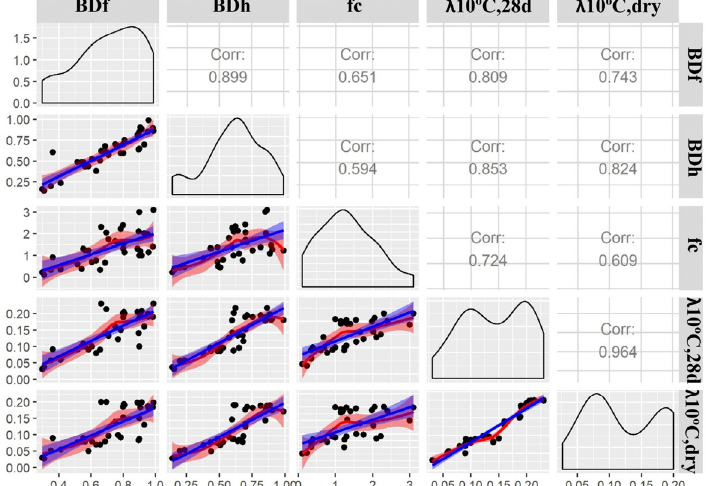
Figure 1. Example of the scatterplot matrix.